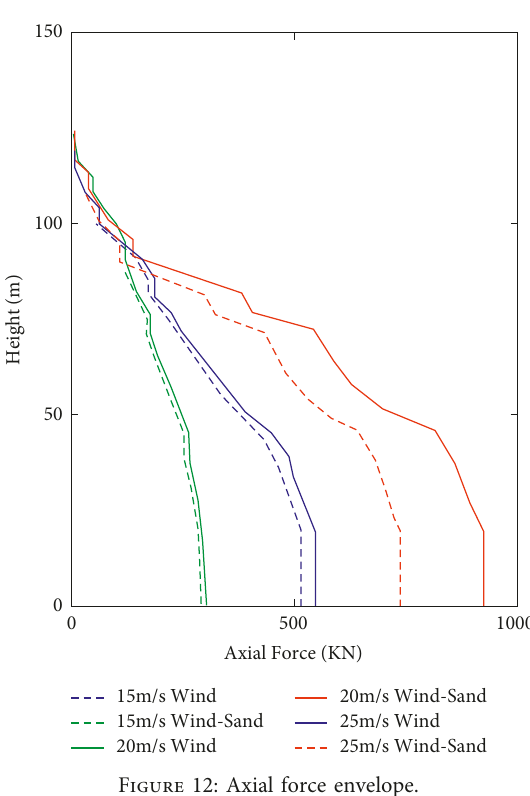
Figure 12: Axial force